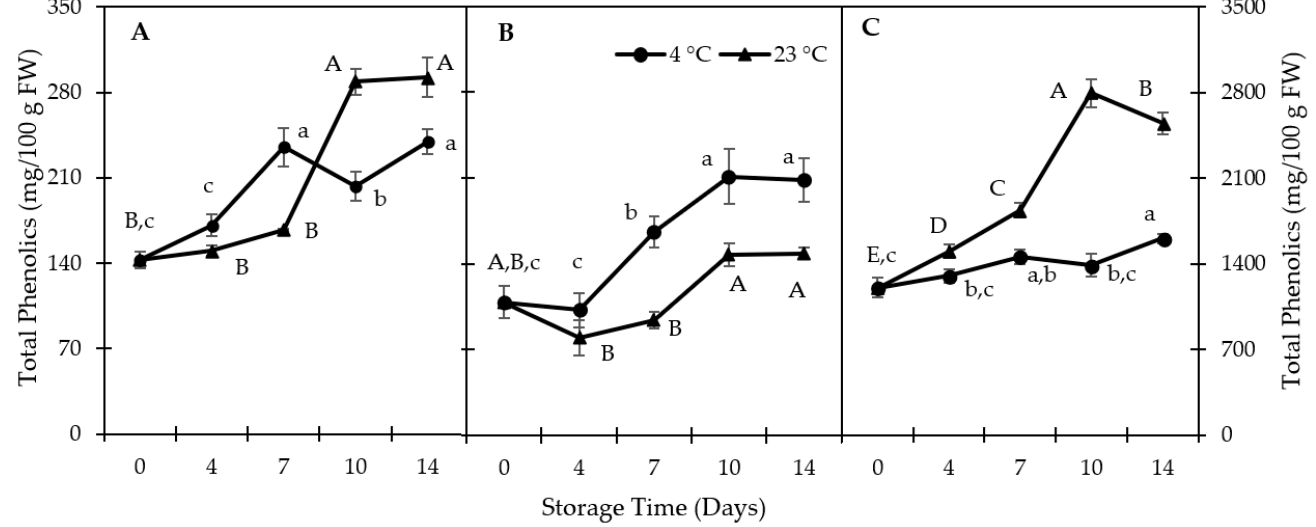
Figure 2. Total phenolic content (TPC) in ( A ) outer flesh; ( B ) inner flesh; ( C ) peel. Data are presented as mean ± SE ( n = 6–10). Different uppercase and lowercase letters indicate significant ( p < 0.05) differences between storage days; FW-fresh weight